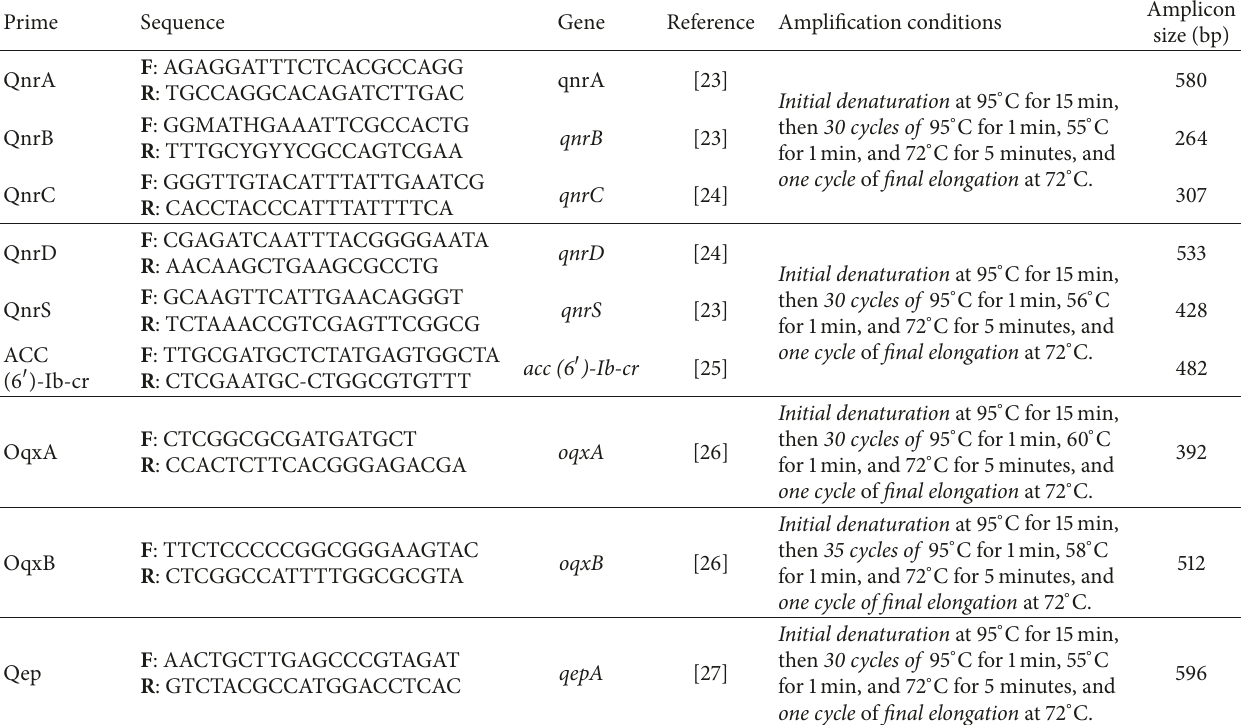
Table 2: Primer sets and PCR cycling conditions used for amplification of genes encoding quinolone resistance.